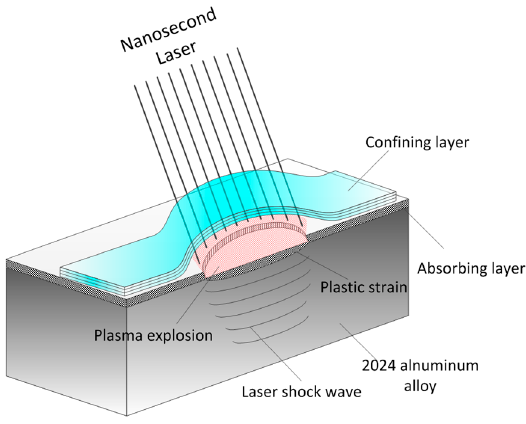
Figure 1. Schematic diagram of laser shock wave.